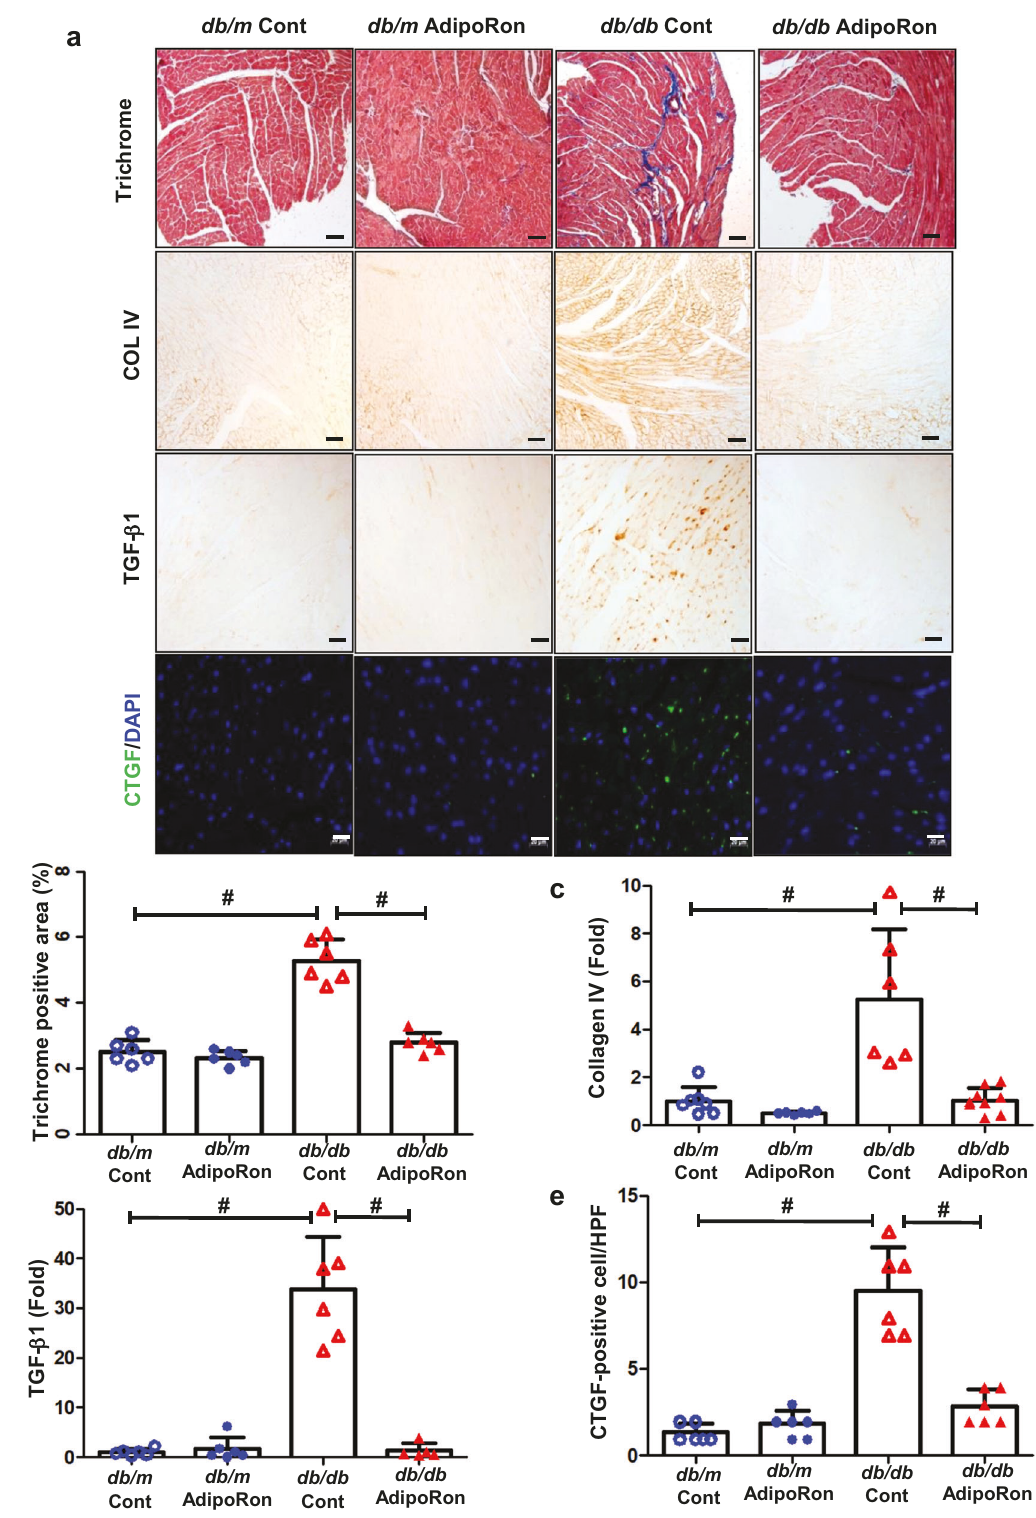
Fig. 2 Changes in the myocardiac phenotypes; fi brosis, in fl ammation, and apoptosis of diabetic and non-diabetic mice with or without AdipoRon treatment. a Representative sections stained with Masson trichrome to estimate the trichrome positive area (%), immunohistochemical staining for type IV collagen, TGF- β 1-positive area, and immuno fl uorescence staining of CTGF-positive cells. b – e Quantitative analyses of the representative sections according to groups. f Representative images of immuno fl uorescence staining of F4/80-positive cells. g Quantitative analyses of F4/80-positive cells. h Representative images of western blotting of arginase I, arginase II, iNOS, and GAPDH levels. i – k Quantitative analyses of representative western blotting images according to groups. l , m Quantitative analyses of MCP-1 and TNF- α in the cardiac tissues according to groups. n Immunohistochemical staining of TUNEL-positive cells. o Quantitative analyses of immunohistochemical staining according to groups. p Representative images of western blotting of Bax/Bcl-2. q Quantitative analyses of Bax/Bcl-2 according to groups * P <0.05, ** P <0.01, and # P <0.001 compared with other groups. Scale bars, 20 μ m (in a , f )/ 100 μ m (in n ). Cell Death and Disease (2022)